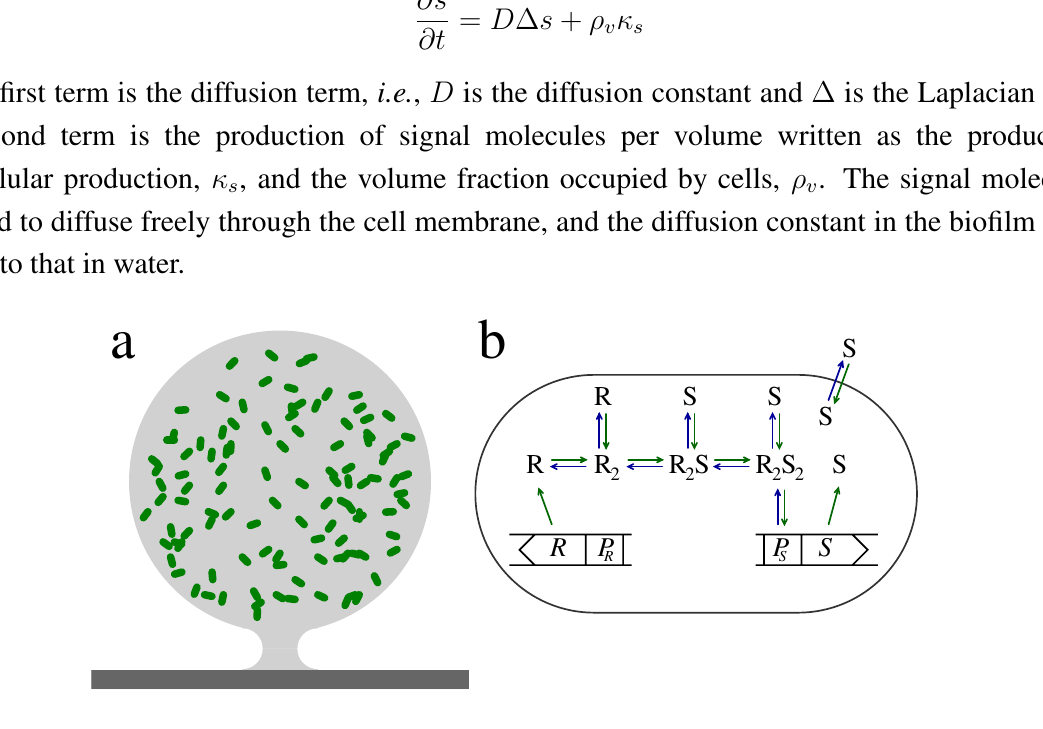
Figure 1. ( a ) Bacteria residing in a spherical biofilm micro-colony attached to a